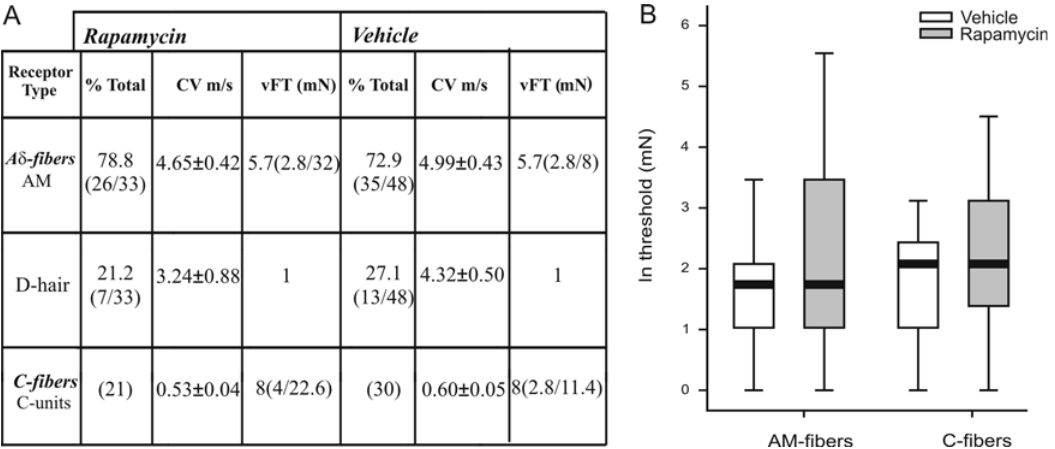
Figure 7. Changes in physiological properties of mechano-sensitive fibers after rapamycin treatment. A . Means 6 SEM are shown. CV, conduction velocity; vFT, Von Frey threshold. Von Frey thresholds are given as the median with the 1st and 3rd quartiles in brackets. B . Box plot of Von Frey thresholds for mechano-sensitive AM- and C- fibers. Data have been normalized by logarithmic (ln) transformation. Horizontal dark bars indicate the median.